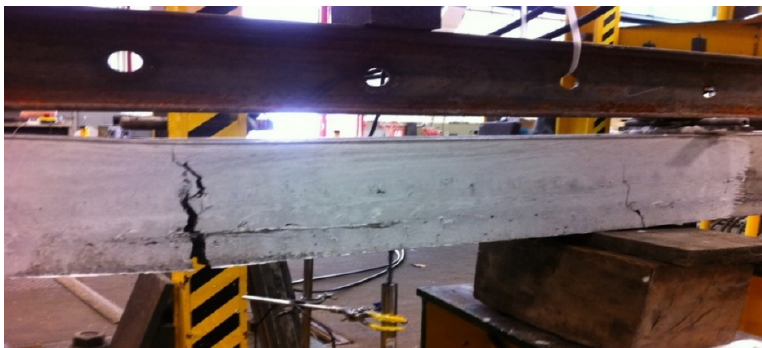
Figure 8. Mid-span load-deflection of large-scale bi-axial TRC beams.